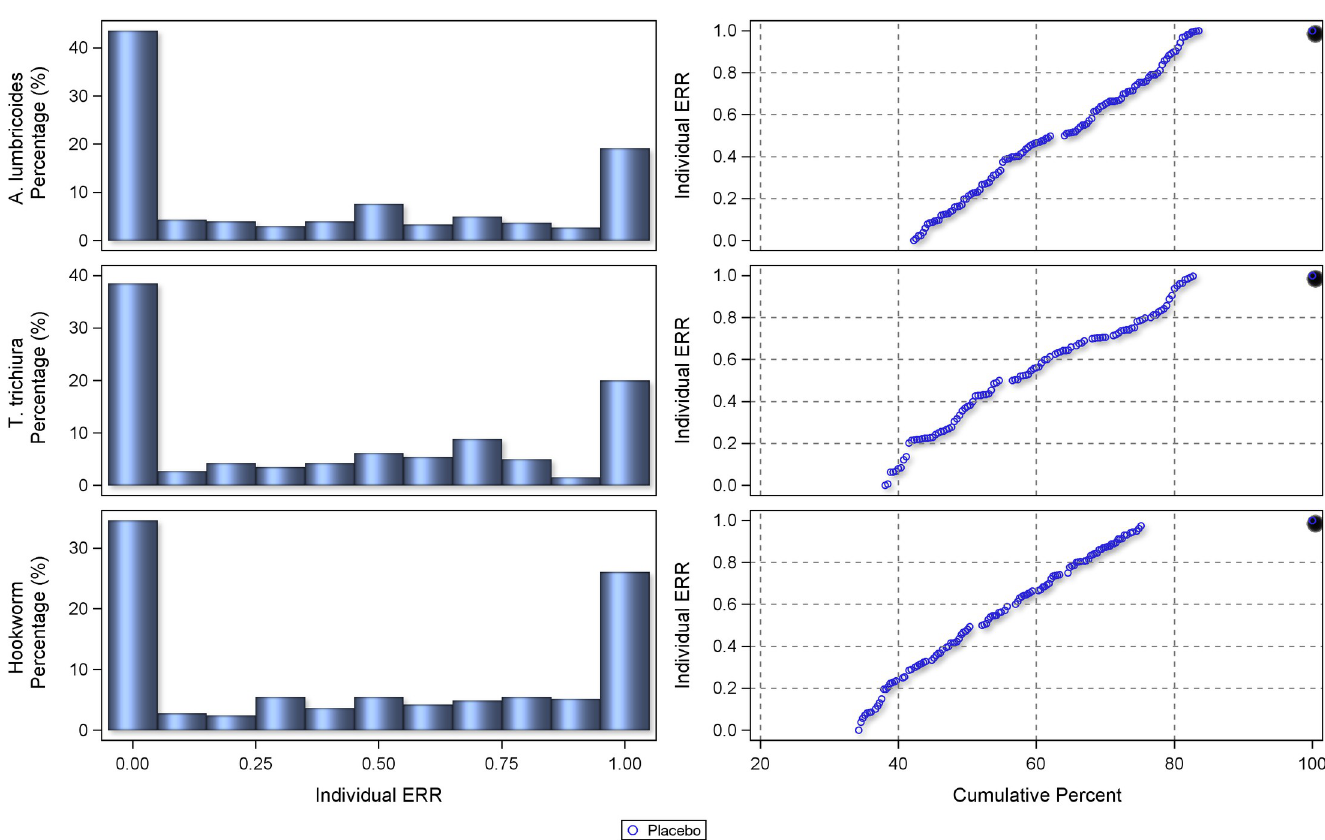
Fig 13. Distribution of individual responses in studies of 22–45 days follow-up for Ascaris lumbricoides , Trichuris trichiura and hookworm for other drugs. The right-hand plots show the proportions of people at a given ERR with colours related to placebo or a drug. The left-hand plots show cumulative distribution of ERR in people treated with a drug from 0 to